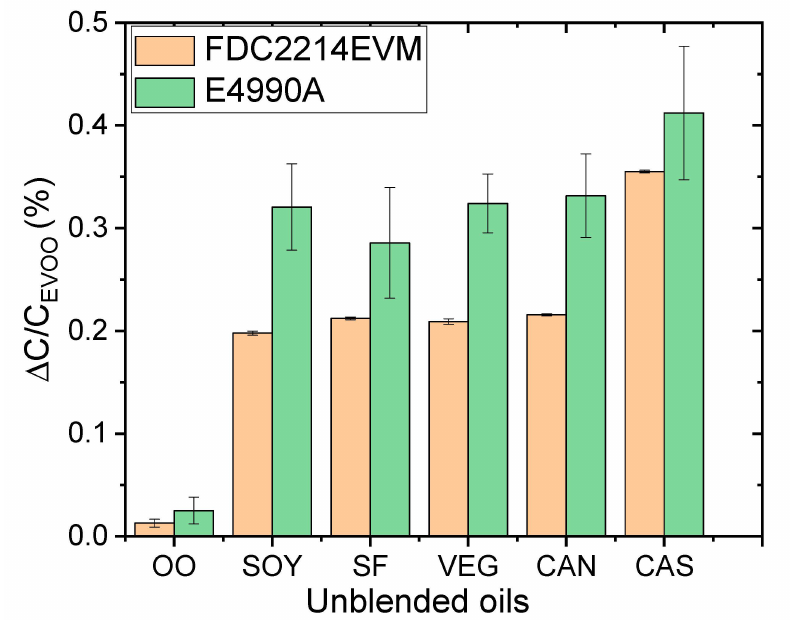
Figure 3. Sensor validation using E4990A (excitation frequency of 5 MHz and V p-p of 1 V): Bar plot comparing ∆ C EVOO /C EVOO ( ± σ ) obtained using FDC2214EVM and E4990A for all unblended used in this study. Olive oil − OO, soybean oil − SOY, sunflower oil − SF, vegetable oil − VEG, canola oil − CAN and castor oil −